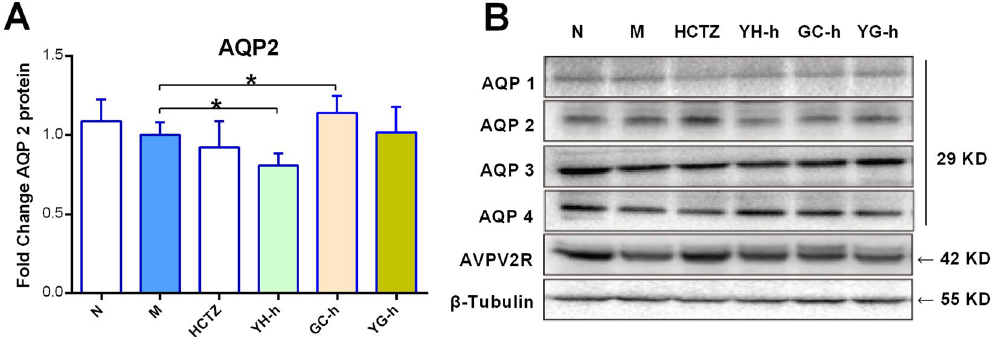
Figure 4. Urine output and urine concentrating ability changes were related to renal AQP 2 expression. Among renal AQPs and AVPV2R proteins, YH decreased AQP 2 expression while GC increased it. Other proteins were not considerably changed, which indicated that total renal AQP 2 may be the key target of YH and GC in diuretic activity. ( A ) Renal AQP 2 expression fold change, average number of M group is set as 1.0 (n = 6). * P < 0.05 as compared between the linked groups. ( B ) Blotting images of diuresis related proteins, including AQP 1, AQP 2, AQP 3, AQP 4 and AVPV2R. According to diuresis evaluation results, high doses of YH, GC and YG were selected for western blotting study, and one representative sample of each group is showed. The blots was cropped properly and the full length blots are presented in Supplementary Fig.